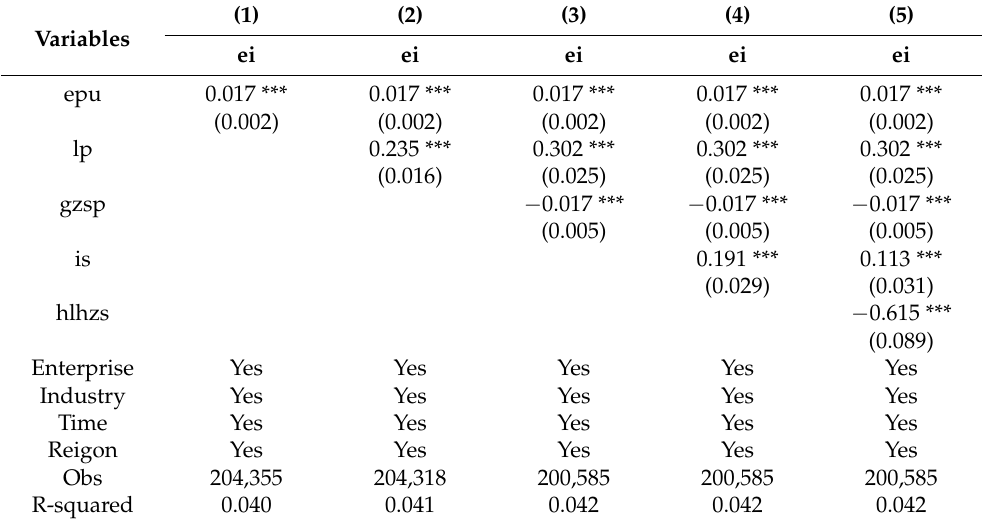
Table 2. Stepwise regression